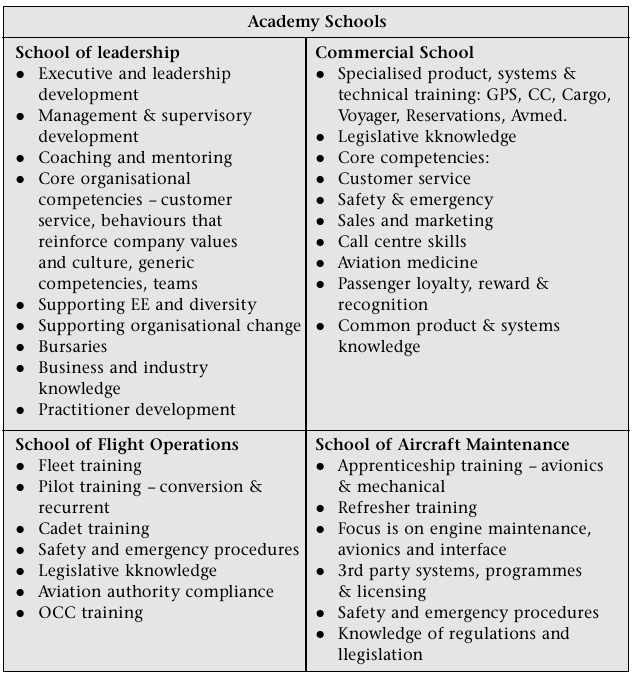
Figure 2: Training Structure of the South African airline firm ( Adapted from Training and Research Document, 2004